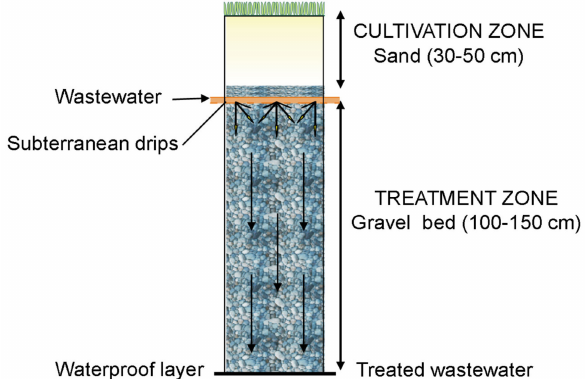
Figure 1. Scheme of a hybrid constructed soil